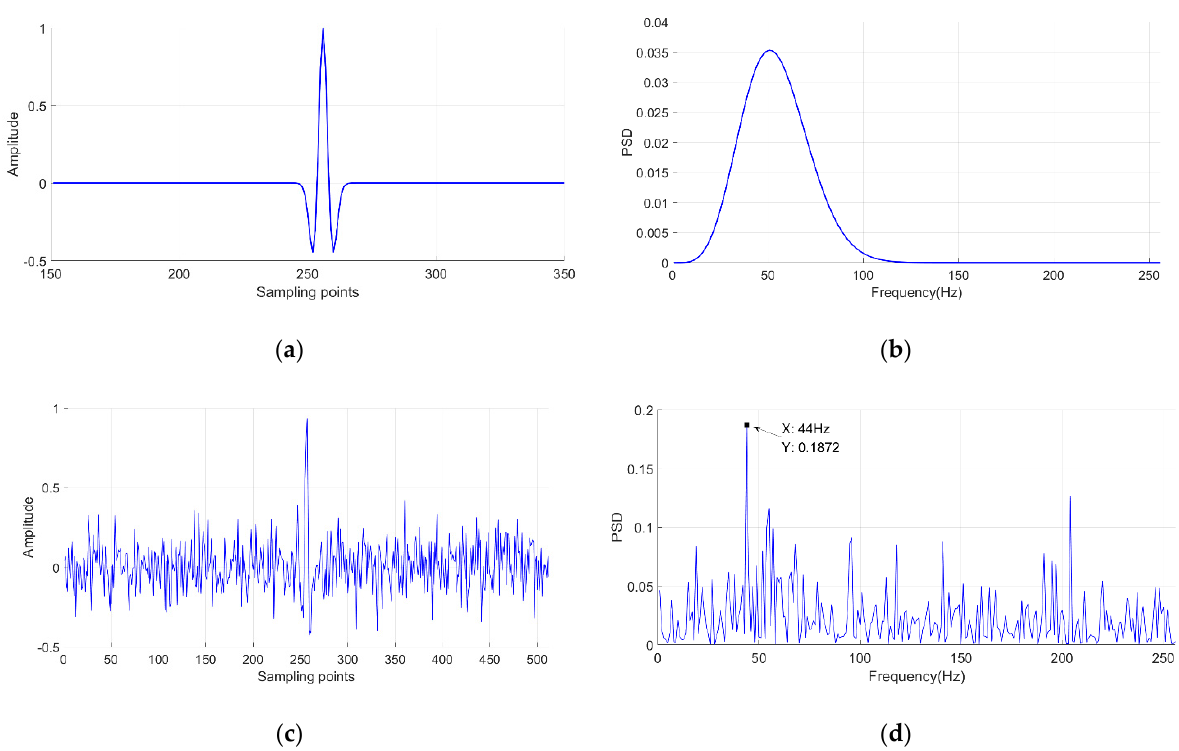
Figure 13. Oscillogram of Ricker wavelet under no noise and noise. f M = 50 Hz. ( a ) Waveform in time domain without noise. ( b ) Power spectrum of ( a ). ( c ) Waveform in time domain with noise, where SNR is − 5 dB. ( d ) Power spectrum of ( c ), and there is a peak on 44 Hz.